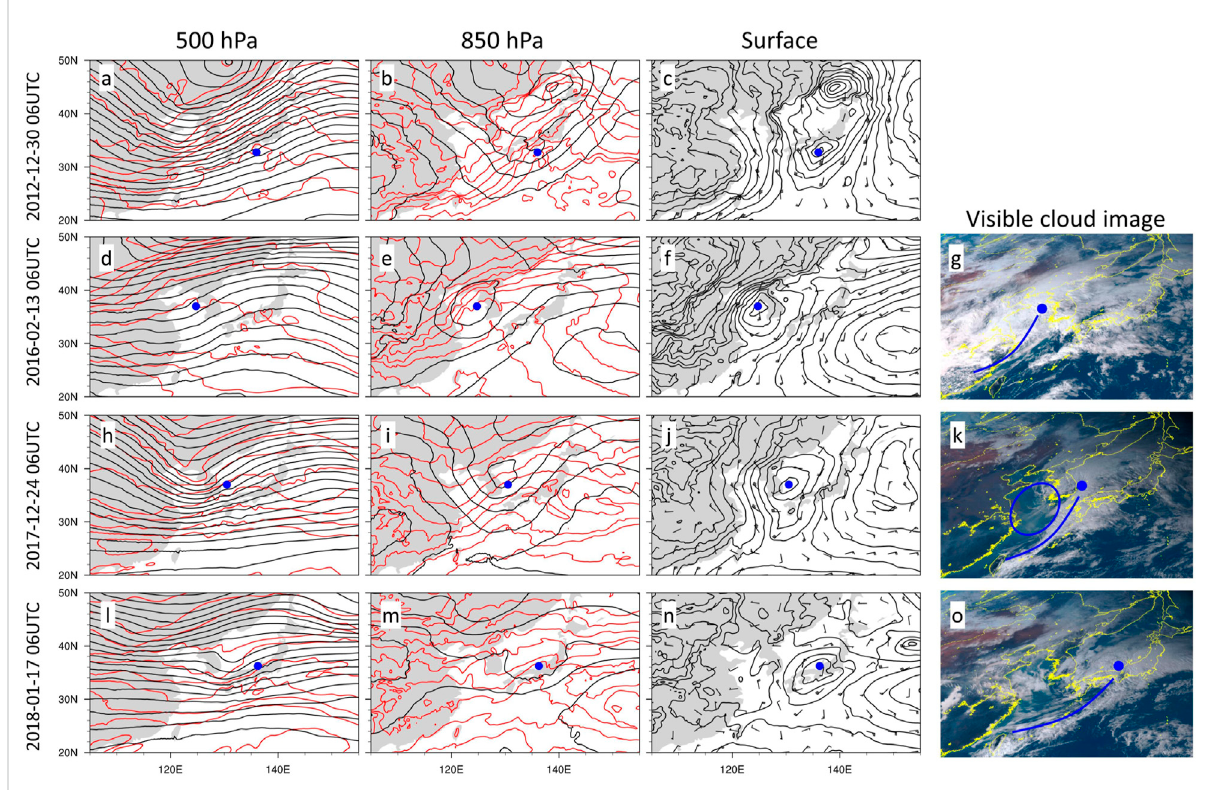
FIGURE 10 Synoptic backgrounds for the four ECs at their early stages. The fi rst/second/third/fourth row shows the situation for EC-2012/2016/2017/ 2018.Thetimeforeachrowismarkedleft.The fi rstcolumnshowsGPH(blackcontourswithintervalof40gpm)andtemperature(redcontourswith interval of 4 ° C) at 500 hPa. The second column is the same as the fi rst column, except at 850 hPa. The third column shows the SLP (black contours withintervalof2.5 hPa)andsurfacewind(windbarbs).Thefourthcolumnshowsthevisiblecloudimagesforthelast3 ECs.Bluedotslocatethe cyclone center,and bluelines infourthcolumnlocate thecold fronts. Theellipsein(n)shows theclear sky areawithsporadiclow cloudsleftbycold